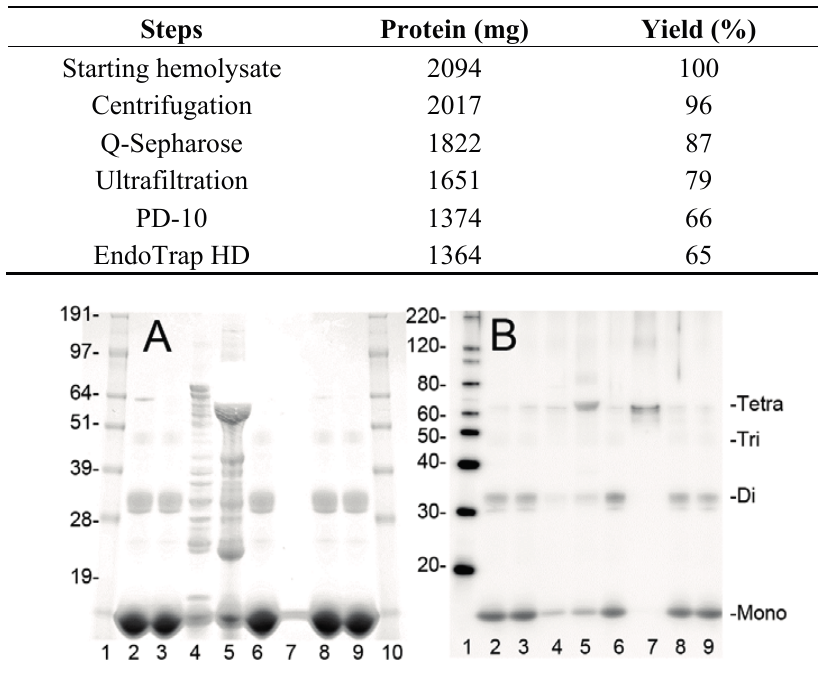
Figure 1. Purification of bovine metHgb. ( A , B ) ~50 or ~5 µg of protein from individual